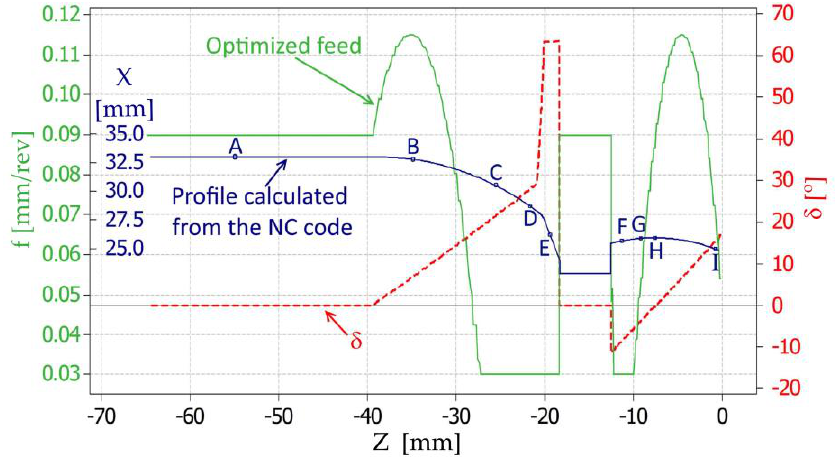
Figure 13. Graph representing the calculated feed rate values f OPTi and the marked contour of the examined surface.